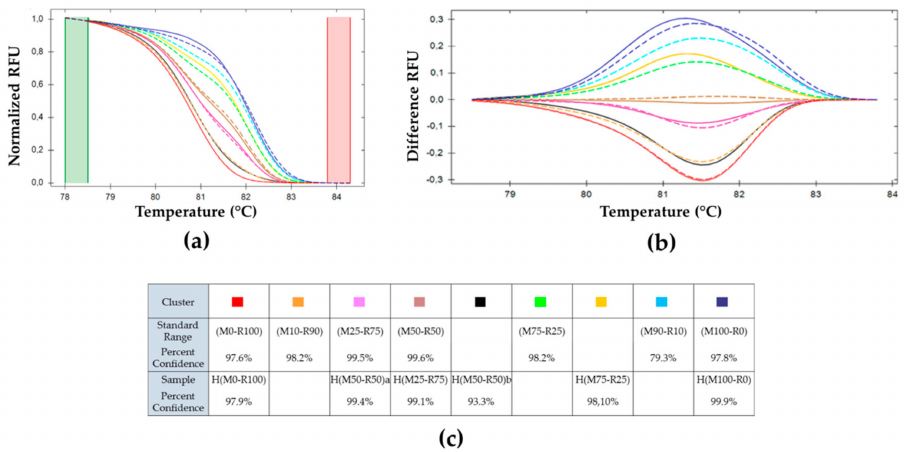
Figure 5. Melting curves analysis of pe38 amplifications using BVs obtained on larvae in conditions of mixed infection and compared to the standard range. ( a ) Normalized RFU. ( b ) First derivative of fluorescence vs. temperature profile, cluster ( ) (M50-R50) of the standard range is used as reference. Cluster of the standard range is represented with dotted lines: ( ) (M0-R100); ( ) (M100-R0); ( ) (M10-R90); ( ) (M25-R75); ( ) (M50-R50); ( ) (M75-R25); ( ) (M90-R10). BVs resulting from each inoculum: ( ) H(M0-R100); ( ) H(M25-R75); ( ) H(M50-R50)a; ( ) H(M50-R50)b; ( ) H(M75-R25) and ( ) H(M100–R0). ( c ) Percent of confidence for each sample belonging to a